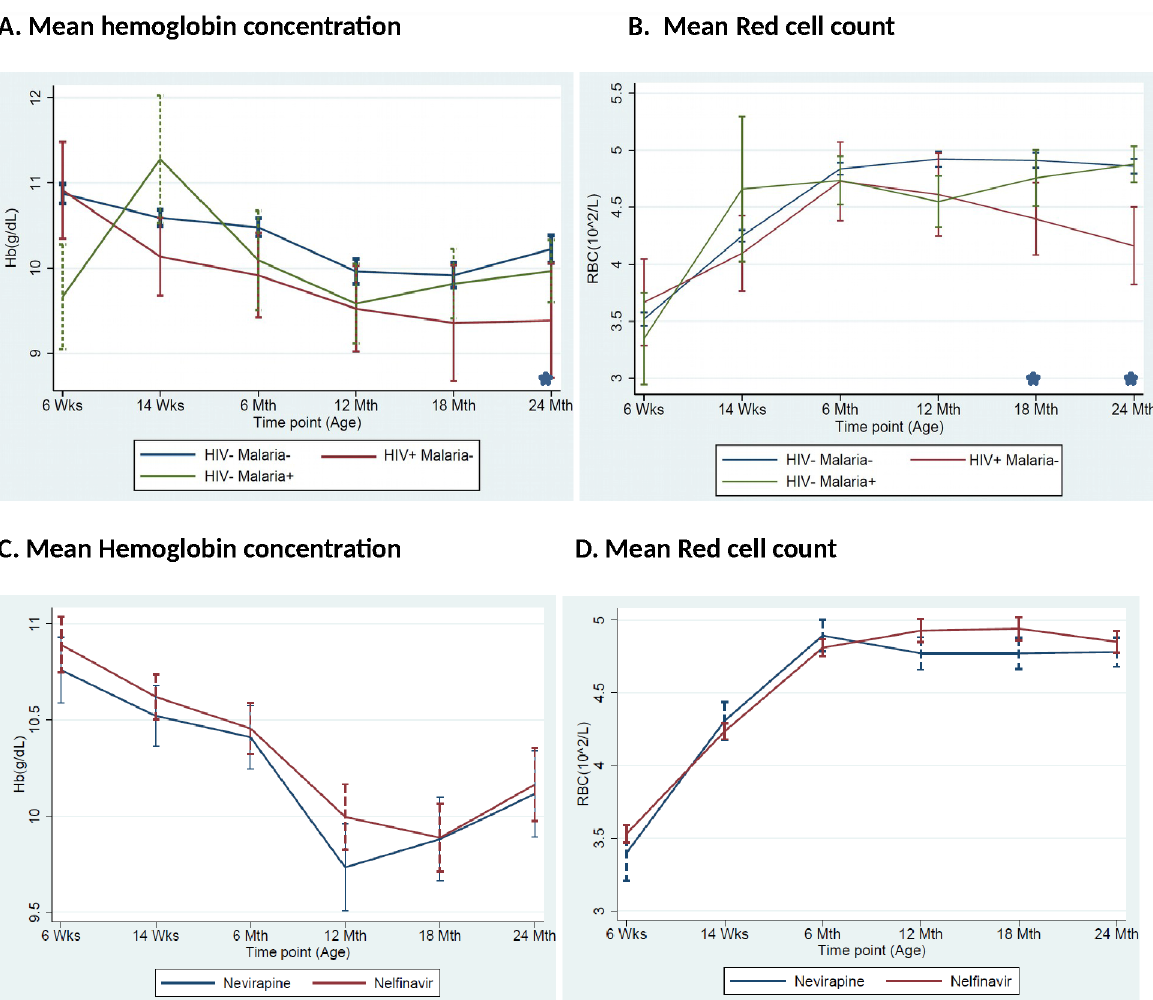
Fig 2. Comparison of mean A) hemoglobin concentration and B) RBC count by malaria infection status and mean C) hemoglobin concentration and D) RBC count by mother ’ s triple-antiretroviral prophylaxis regimen in children, Kisumu Breastfeeding Study, Kisumu, Kenya, July 2003- February 2009. ( * p < 0.05). HIV+ Malaria + omitted from graphs (2A and 2B) because of small sample